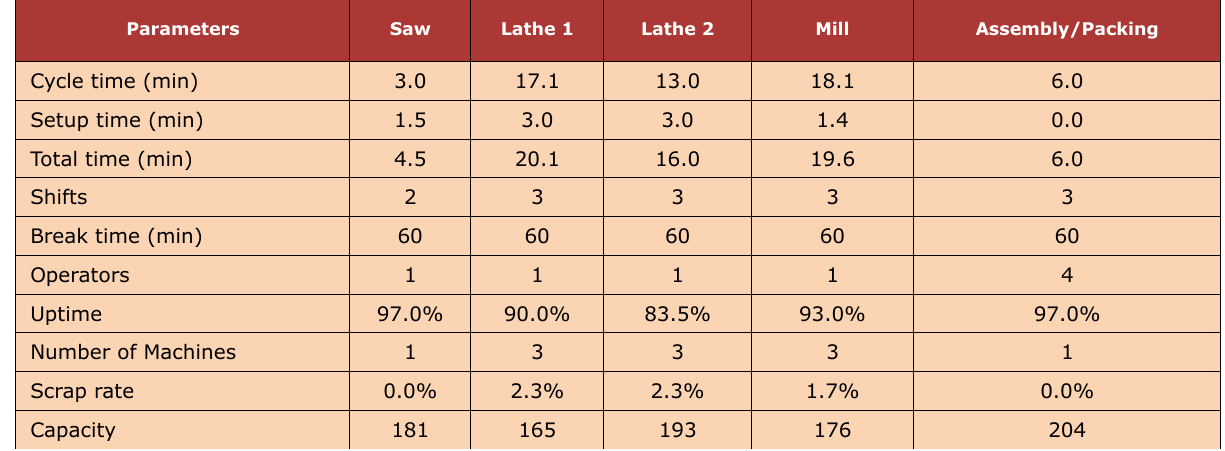
Table 4. Capacity analysis of three Lathes and three Mills